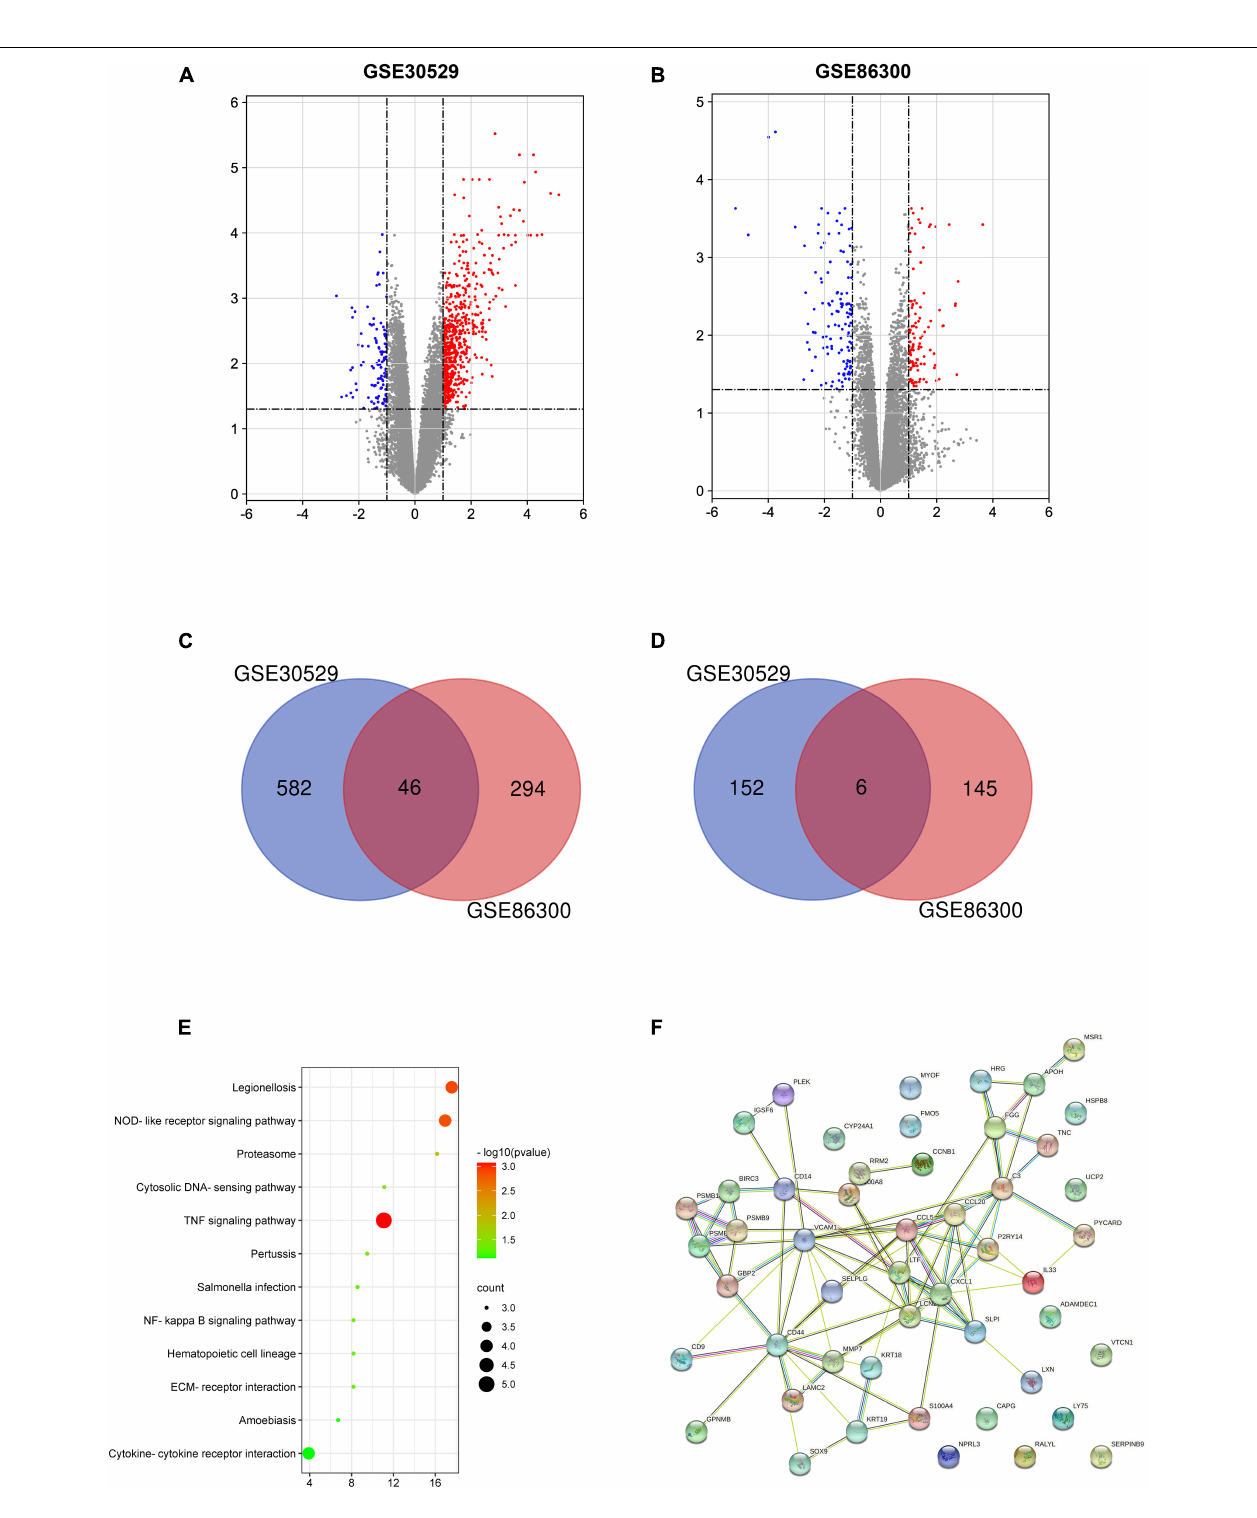
FIGURE 1 | Volcano plot, Venn diagram, PPI network and the most significant module of DEGs. DEGs with a fold change > 1 among the mRNA expression profiling sets GSE30529 (A) and GSE86300 (B) were selected. Forty-six overlapping of upregulated genes (C) and 6 overlapping downregulated genes (D) were identified in the two datasets. (E) The overlapping genes were analyzed by KEGG analysis. (F) The PPI network of overlapping genes.